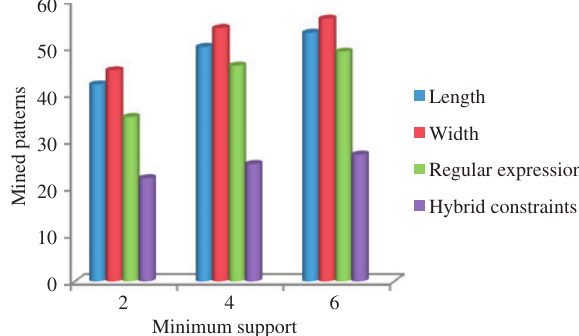
Figure 4: Number of Patterns Mined Using Different